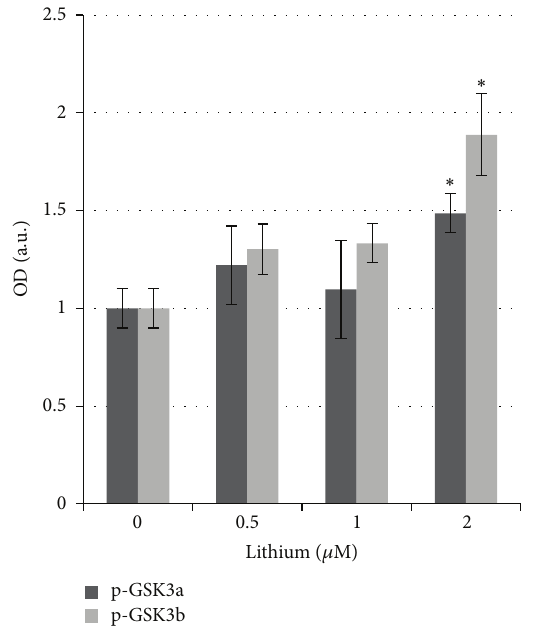
Figure 7: Analysis of the level of GSK3 phosphorylation in PC12 cells treated with lithium (0.5, 1, 2mM) for 48 hours. Quantification data of western blot analysis of the phosphorylation of GSK3 𝛼 Ser 21 and GSK3 𝛽 Ser 9 . Averages ± SEM of three independent experiments. ANOVA with Bonferroni’s-corrected 𝑡 -test. ∗ 𝑃 < 0.01 versus untreated